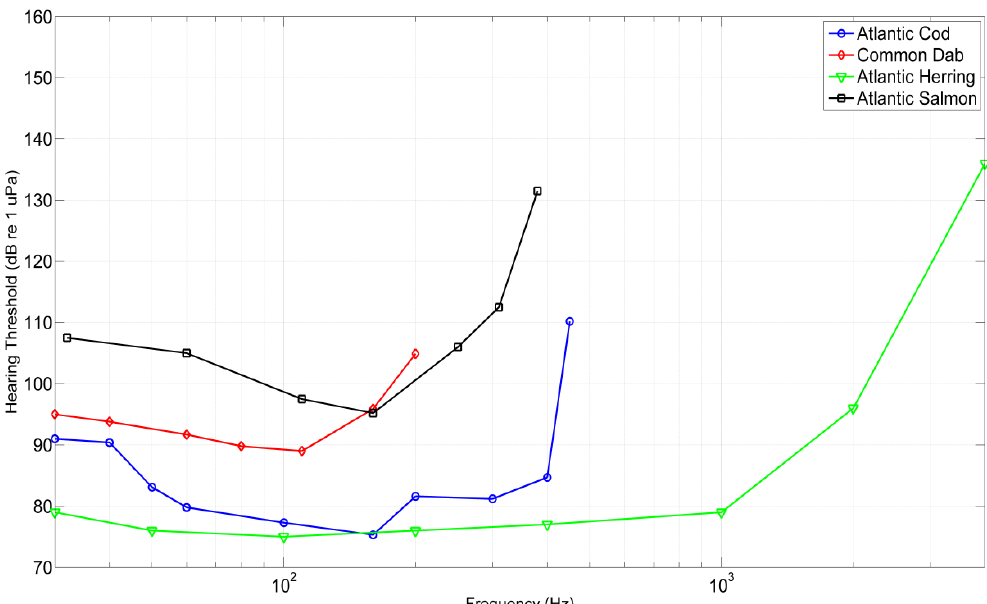
Figure 2. Hearing threshold audiograms of four different species that can be found